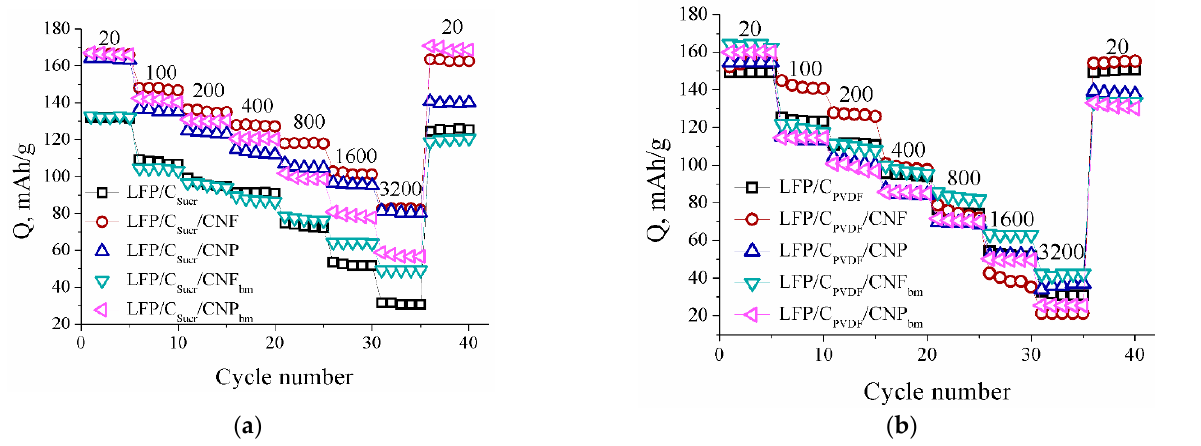
Figure 3. Change in discharge capacity during cycling of the composites prepared using sucrose ( a ) and PVDF ( b ) as carbon sources. The numbers over the curves indicate current densities (mA/g).